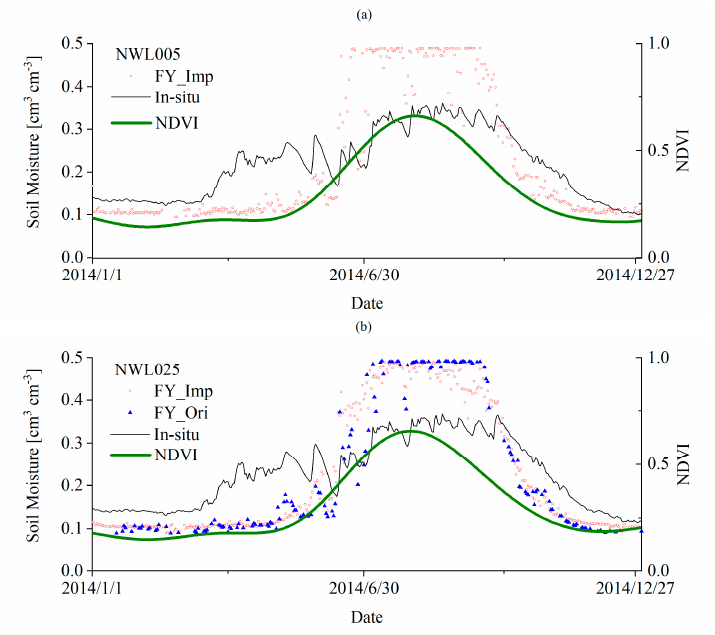
Figure 8. Time series of FY_Imp soil moisture (SM) and FY_Ori SM compared with in situ measurements for 2014. ( a ) FY_Imp SM at NWL005; ( b ) FY_Ori and FY_Imp SM at NWL025.